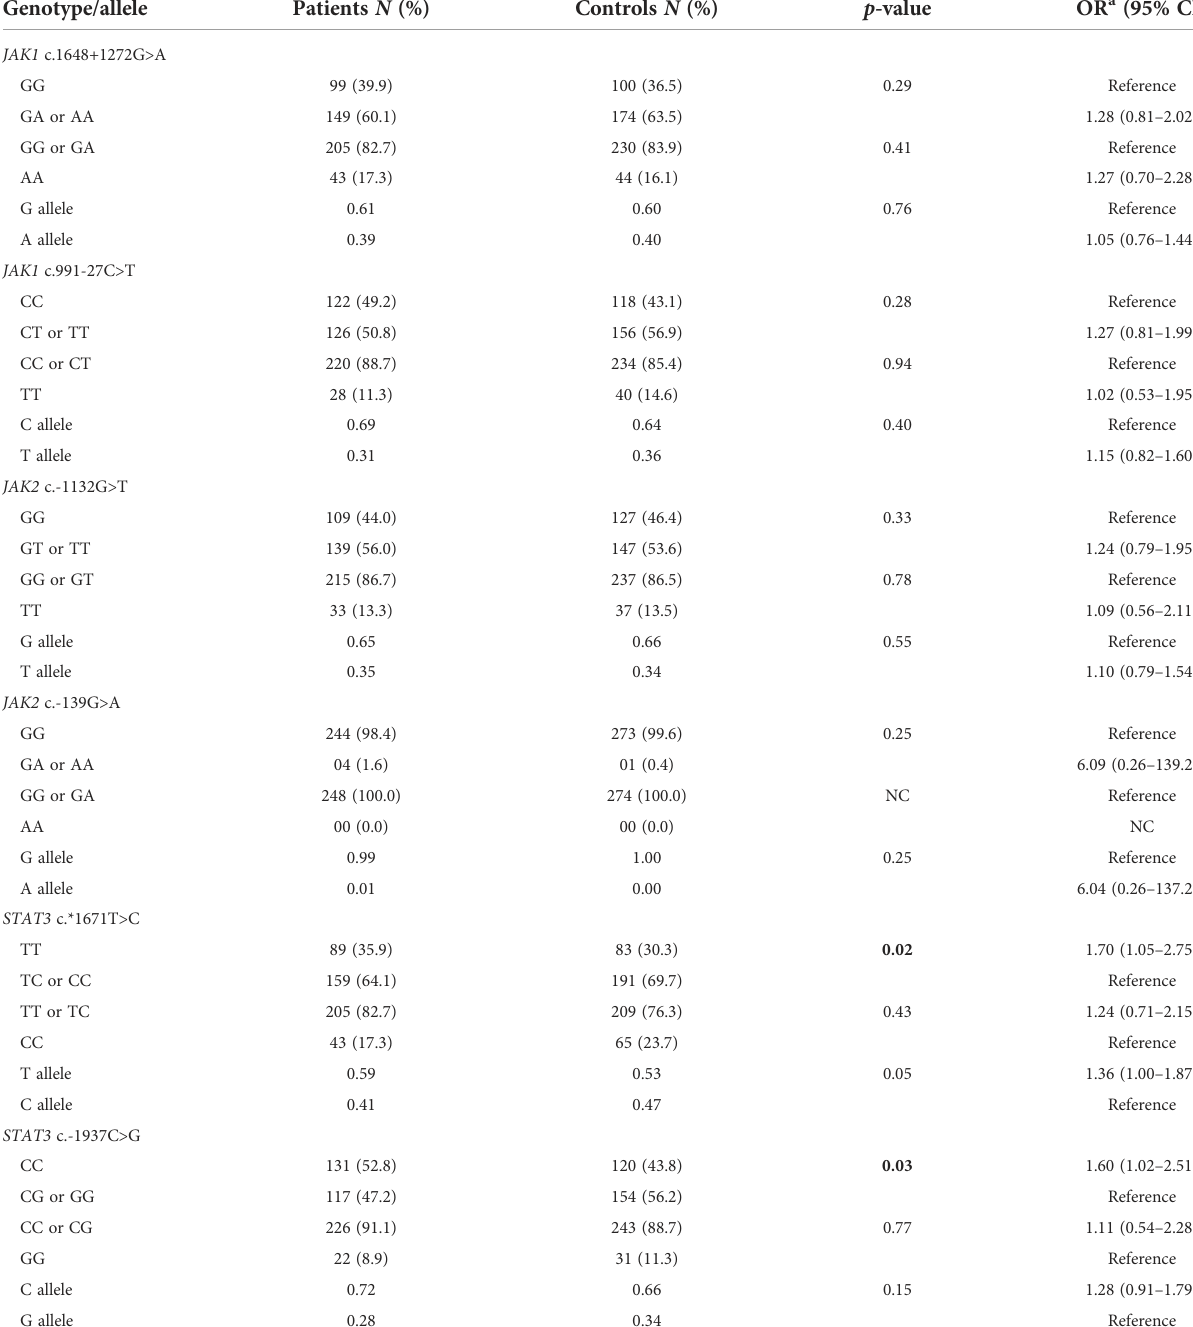
TABLE 2 JAK1 , JAK2 and STAT3 genotypes and alleles in 248 cutaneous melanoma patients and 274